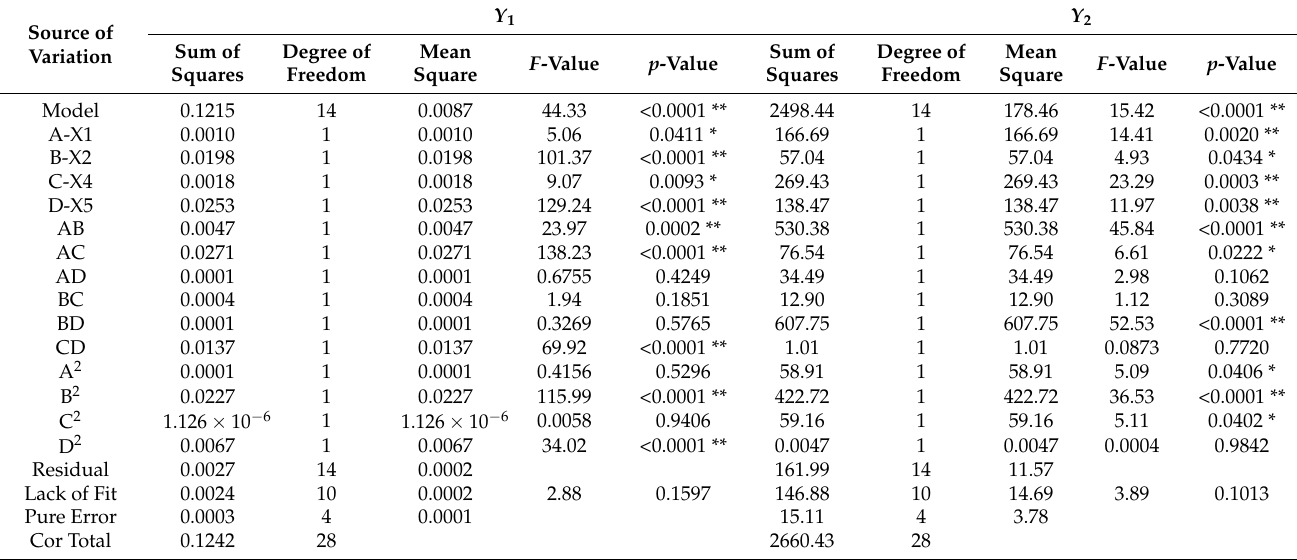
Table 11. Box–Behnken test program and results.